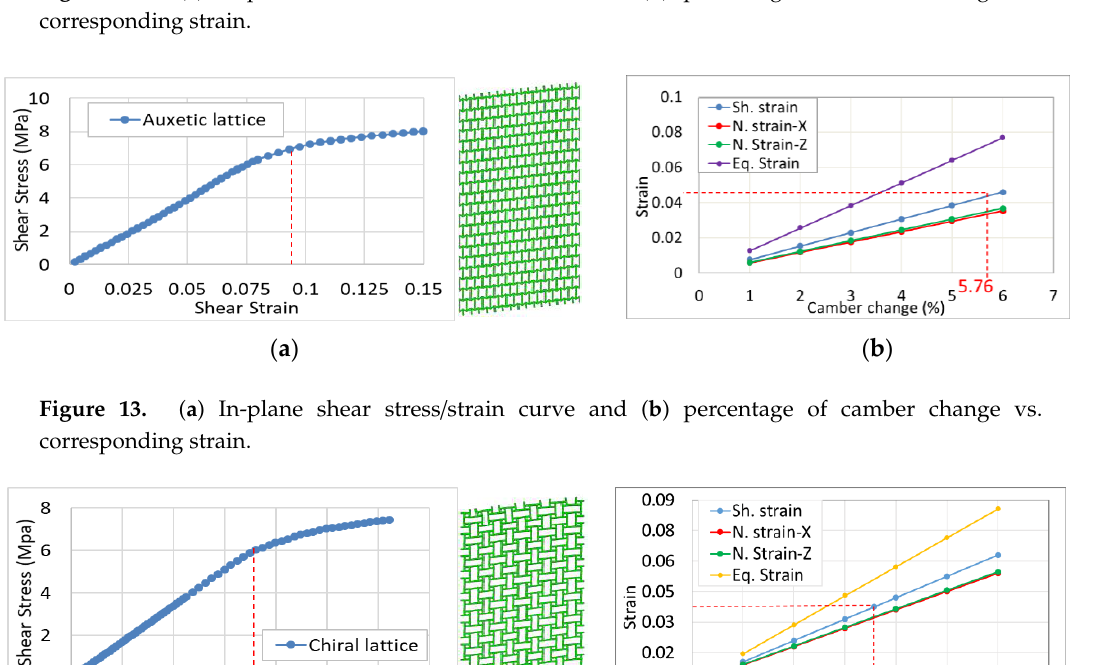
Figure 13. ( a ) In-plane shear stress/strain curve and ( b ) percentage of camber change vs. corresponding strain.